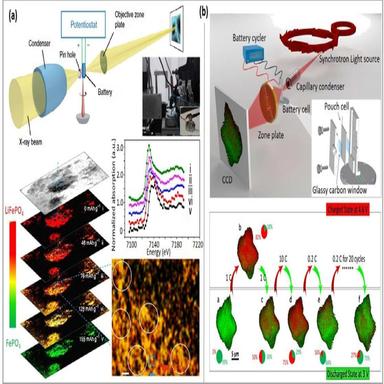
(a) The scheme and photogram of in-situ XAS measurement (upside) and 2D chemical mapping of LFP electrodes at a charge rate of 0.1C (downside) in the LFP/Li battery (Reproduced with permission from ref. Copyright 2014 Springer Nature); (b) schematic diagram of in-situ spectroscopic instrument and the pouch cell (upside), real-time tracing of the chemical heterogenization of a LiCoO2 individual up to 20 cycles (downside) (Reproduced with permission from ref. Copyright 2017 Americ